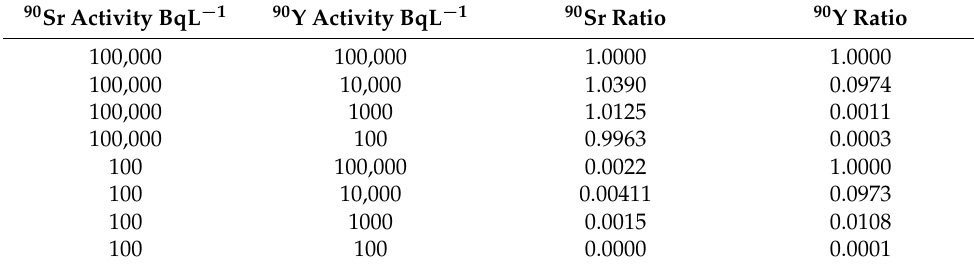
Table 2. The ratios of 90 Sr and 90 Y mixed to different activities as determined by linear regres- sion